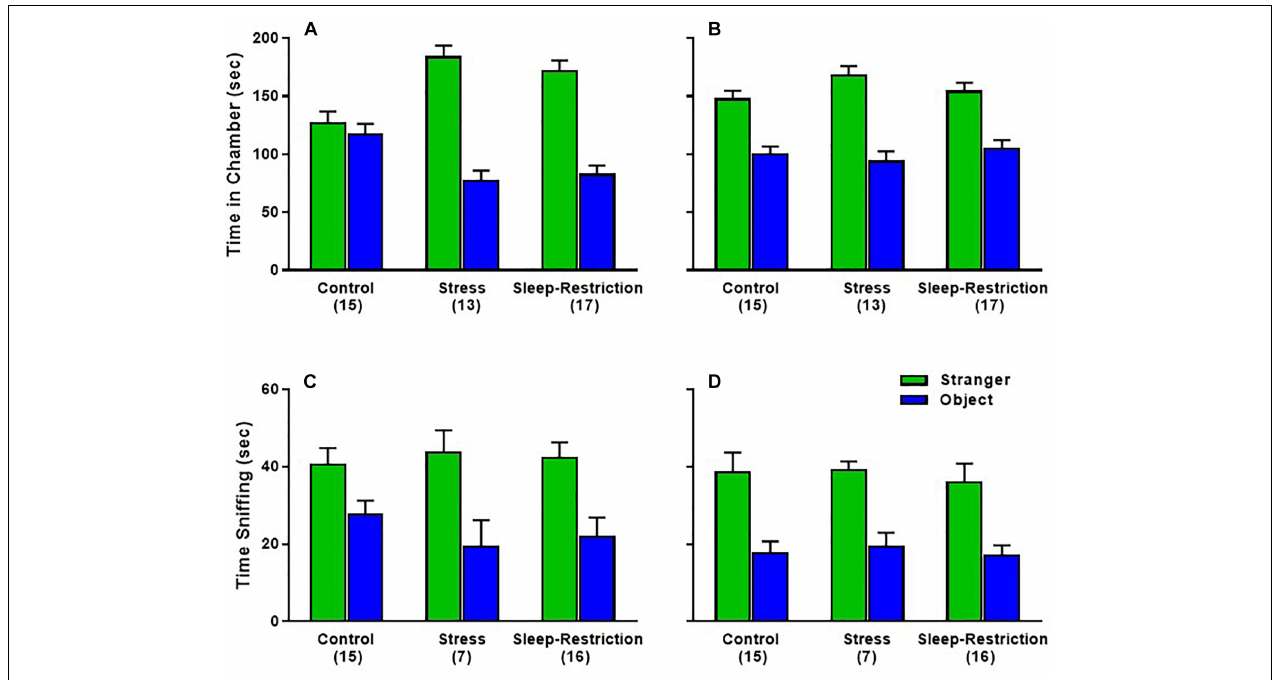
FIGURE 7 | Effects of sleep-restriction on sociability measured at P48 (A,C) and at P90 (B,D) after recovery. Results of ANOVA are given in Table 2 . (A,B) Time in Chamber: there was a significant age × condition × chamber interaction ( p = 0.021). Post hoc t -tests indicate that only control animals at P48 did not have a significant preference for time in the chamber with the stranger mouse compared with the object. All other groups were statistically significant ( p < 0.003). (C,D) Sniffing time: there were no statistically significant effects regarding condition. The main effect of chamber ( p < 0.001) indicates that all mice, regardless of condition or age, showed a clear preference for the stranger mouse compared with the object. The main effect of age ( p < 0.05) indicates that regardless of condition or chamber, mice sniffed less at P90 compared with P48. Ear bar is the mean ± SEM for the number of mice indicated in parentheses.